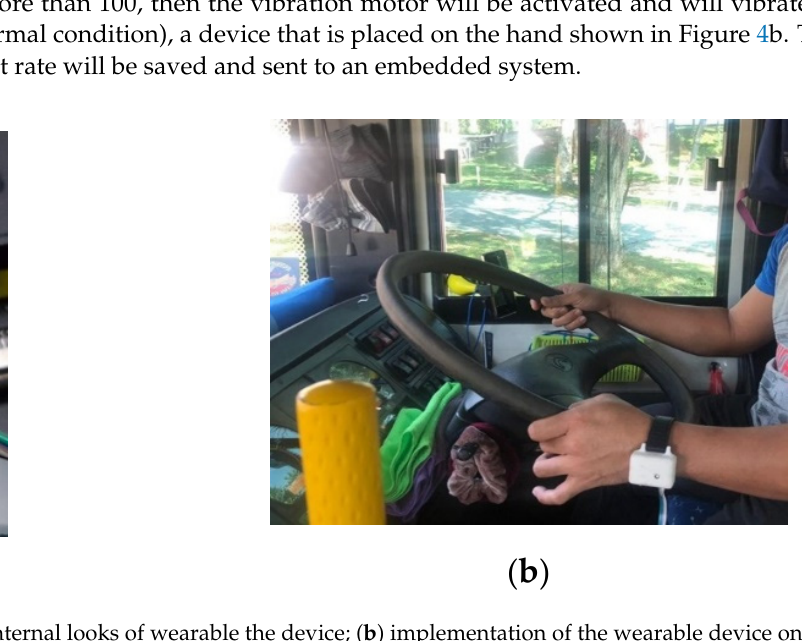
Figure 4. ( a ) Internal looks of wearable the device; ( b ) implementation of the wearable device on the driver’s arm.